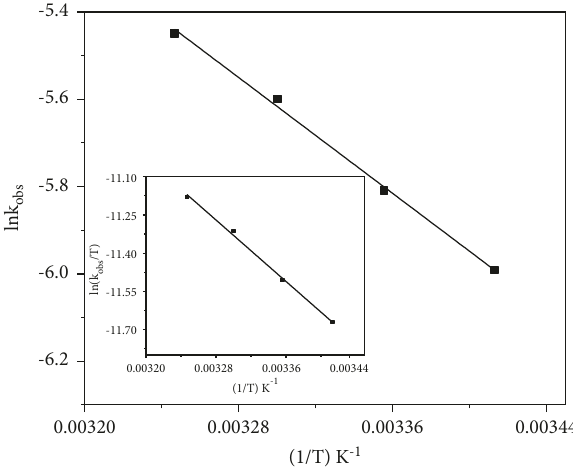
Figure 4: Plot of Arrhenius relation at the following conditions: [Ce (IV)] � 6.0 × 10 − 4 moldm − 3 and [Maltose] � 6.0 × 10 − 3 moldm − 3 and [H + ] � 0.4moldm − 3 . The inset shows plot of Eyring equation.